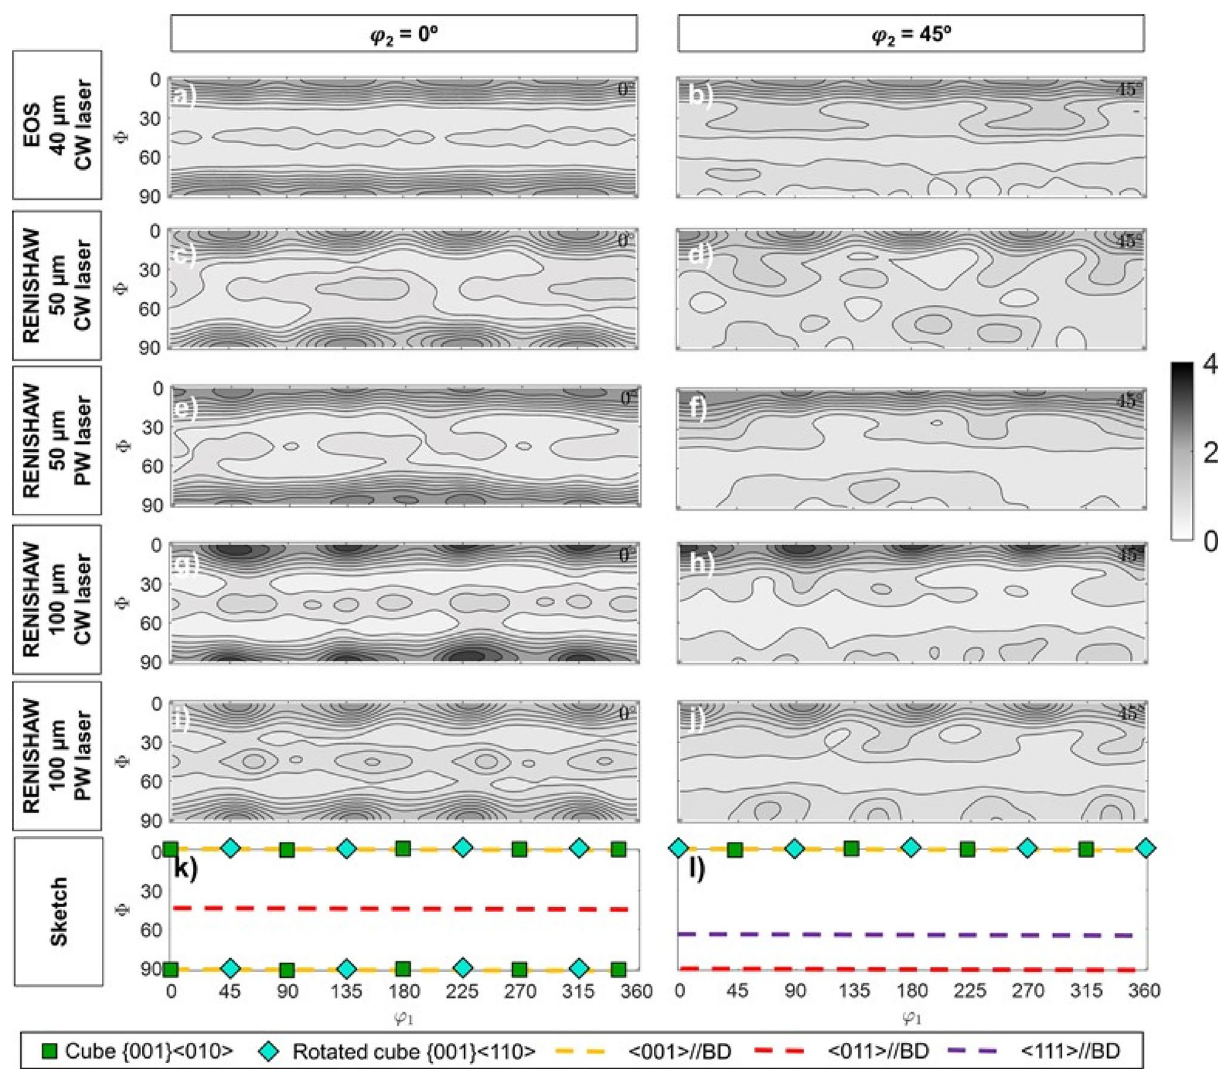
Figure 2. ( a , c , e , g , i , k ) ϕ 2 = 0° and ( b , d , f , h , j , l ) ϕ 2 = 45° ODF sections corresponding to the martensitic matrix of the top layer of the samples ( a – j ) and to a sketch depicting some important texture components or textures that are named in the main text ( k , l ). Data corresponds to ( a , b ) EOS—40 μm—CW laser; ( c , d ) RENISHAW—50 μm—CW laser; ( e , f ) RENISHAW—50 μm—PW laser; ( g , h ) RENISHAW—100 μm—CW laser and ( i , j ) RENISHAW—100 μm—PW laser. Intensities correspond to the color bar on the right-hand side, where the units are multiples of random distribution